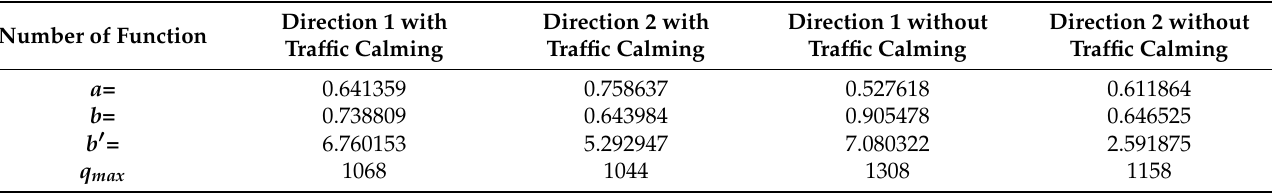
Table 1. Function parameter